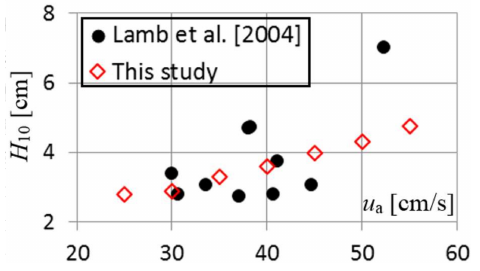
Figure 11. Lutocline height, based on the location of the C = 10 g/L level, as a function of wave forcing, u a , for the main parameter configuration (diamonds, setting of C * is irrelevant) and laboratory experiments (circles) [23], Table